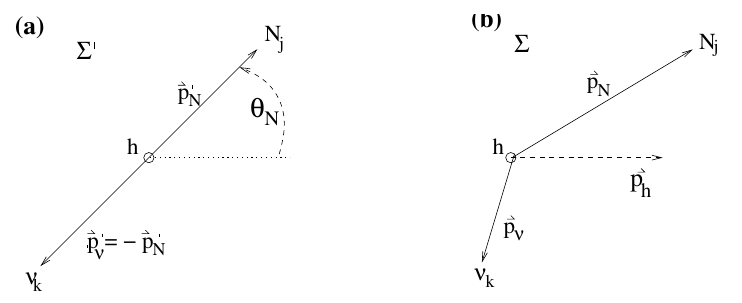
Figure 4 . (a) The 3-momenta of the produced particles in the decay h → N j ν k in the Higgs rest frame ( Σ 0 ); (b) the same, but in the lab frame ( Σ